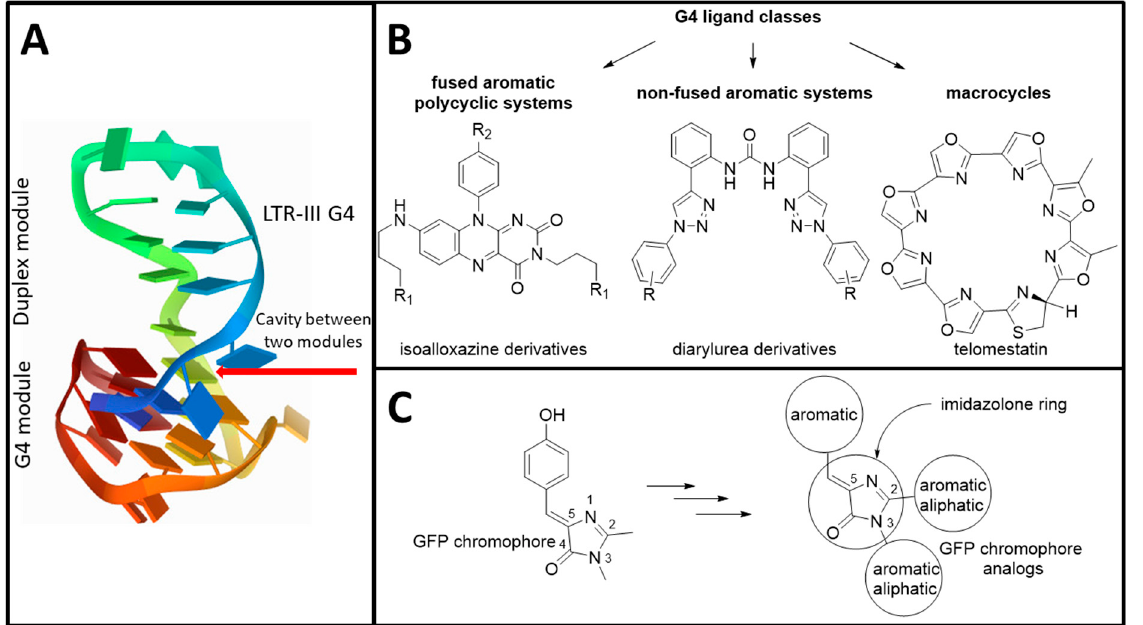
Figure 1. G4 target studied and the principles of ligand design: ( A ) HIV-1 LTR-III G4 structure (PDB 6H1K); ( B ) major types of G4-binding compounds; ( C ) the structure of GFP chromophore and its synthetic derivatization strategy.